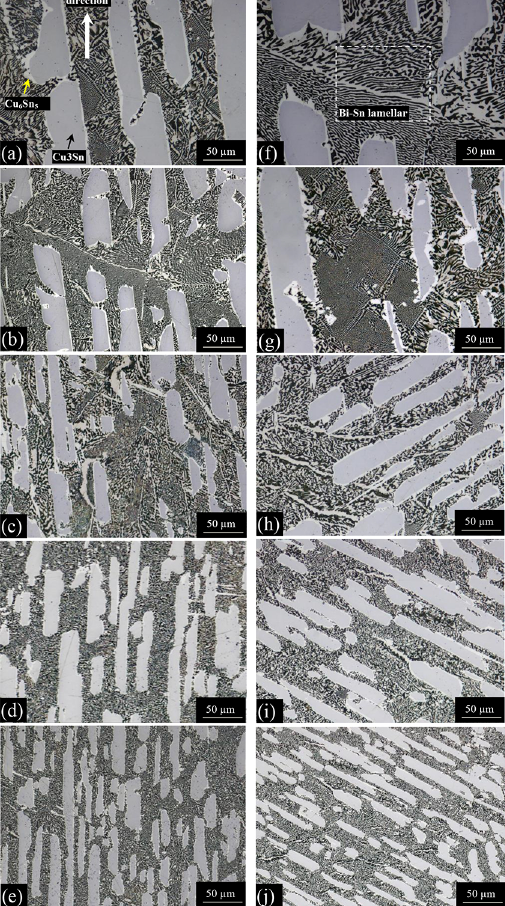
1.41 µm, λ (lamellar) decreased from 2.89 to 1.50 µm, λ T